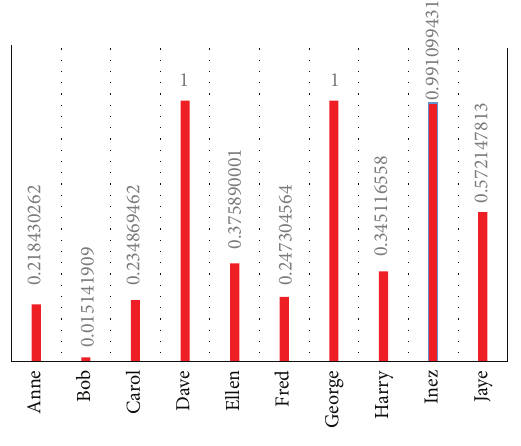
Figure 3: Priority list of EZ